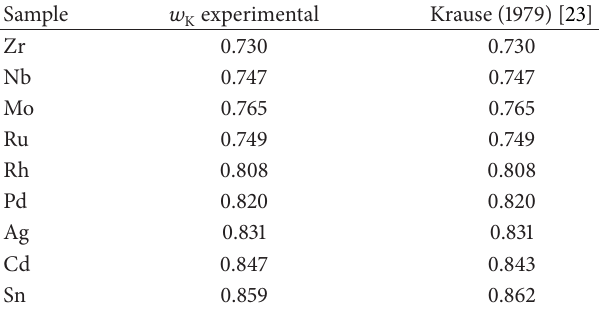
Table 3: K shell X-ray fluorescence yields.